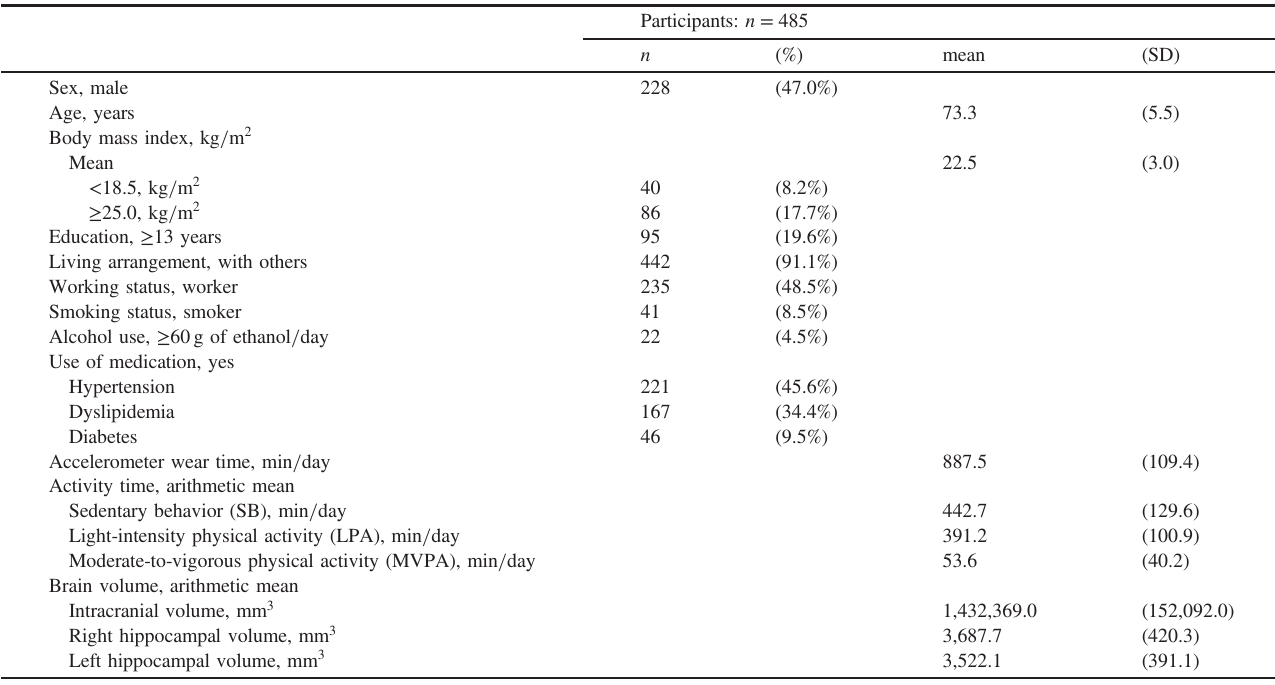
Table 1. Participants ’